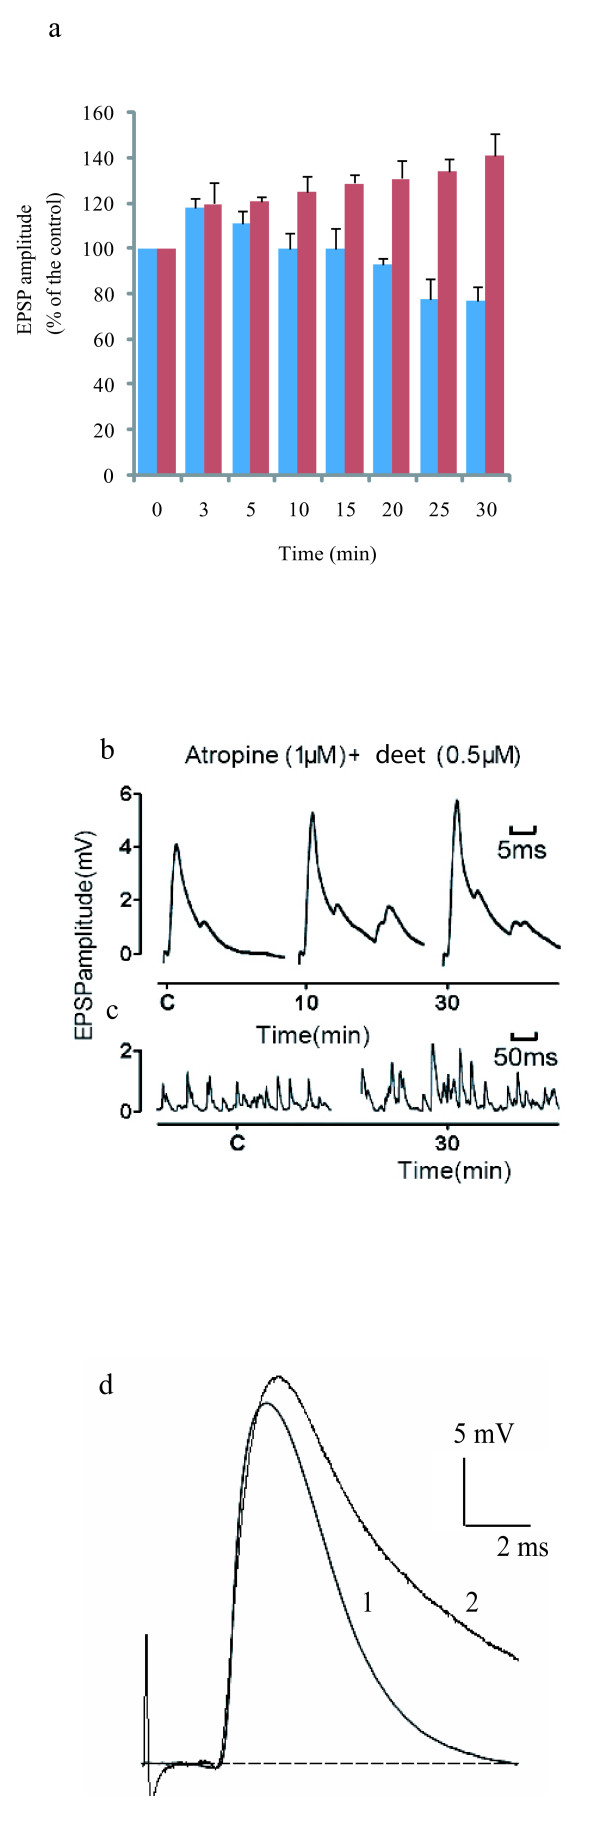
Effects of deet on insect and mammalian neuronal preparations. a) The Histogram illustrates the excitatory postsynaptic potential (EPSP) amplitudes (% of control) versus time (min) after exposure to 1 μM of deet in absence (blue bars) and in the presence of atropine (red bars) in P. americana central nervous system. Application of deet without atropine (blue bars) induced a biphasic effect on EPSP amplitudes. Within the first 3 min, application of deet induced a significant increase of EPSP amplitude which reflected an elevation of acetylcholine (ACh) concentration in the synaptic cleft (see text for details). After 3 min, a significant EPSP depression was observed, suggesting a regulation of ACh concentration in the synaptic cleft through an activation of presynaptic muscarinic receptors. Pre-treatment for 10 min with atropine 1 μM (red bars) clearly reversed the EPSP depression observed with deet 1 μM, confirming the participation of the muscarinic receptors in the negative feedback of ACh release following deet exposure. Data are means ± S.E.M. b) and c) Typical examples of cockroach composite (b) and unitary (c) EPSP following deet application. Experiments were done in the presence of atropine (1 μm) to prevent an action of presynaptic muscarinic receptors. Note the increase of unitary EPSP frequency and amplitude (c) following deet application (0.5 μM) in the synapses. d) Effect of deet on the time course of full size endplate potentials (EPPs) recorded in a mouse hemidiaphragm preparation bathed with a standard Krebs-Ringer solution supplemented with 1.6 μM μ-conotoxin GIIIB to selectively block sodium channels in muscle fibres. The EPPs recorded under control conditions (trace 1), and after the addition of 500 μM deet to the medium (trace 2); note the prolongation of the decay phase of EPPs in the presence of deet, with little change in the amplitude and time to peak; the mean decay-time constant were 11.1 ± 0.7 and 3.8 ± 0.08 ms for deet-treated and controls, respectively (n = 6, P < 0.001).